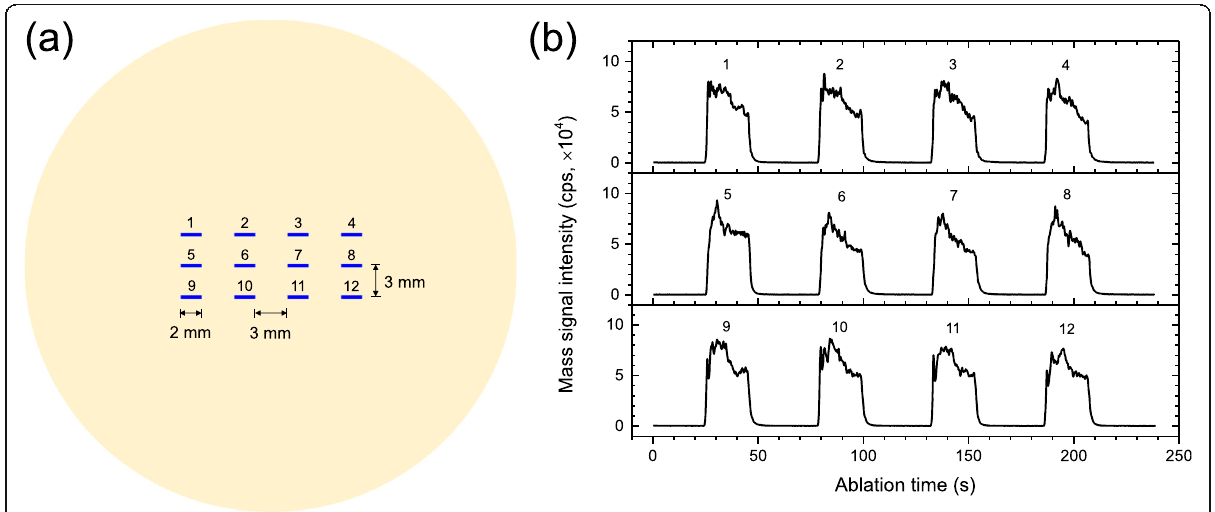
Fig. 1 ( a ) Twelve line-scan positions on the ion-exchange membrane filter surface and ( b ) the corresponding 75 As mass signal intensity profiles obtained by fs LA-ICP-MS. In a , the blue lines represent the 2-mm long line-scan positions. The line-scan position and the corresponding mass signal profile are indicated by the same number